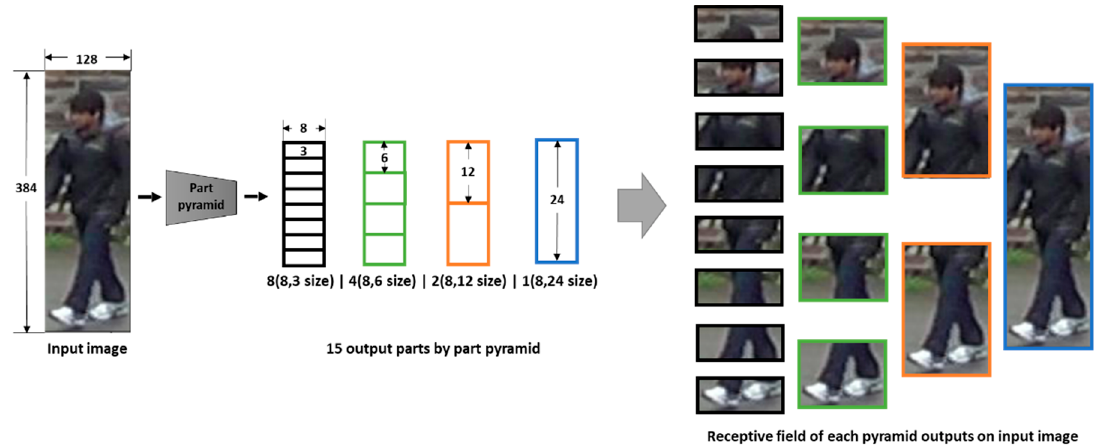
Figure 6. Receptive field example of part pyramid on input